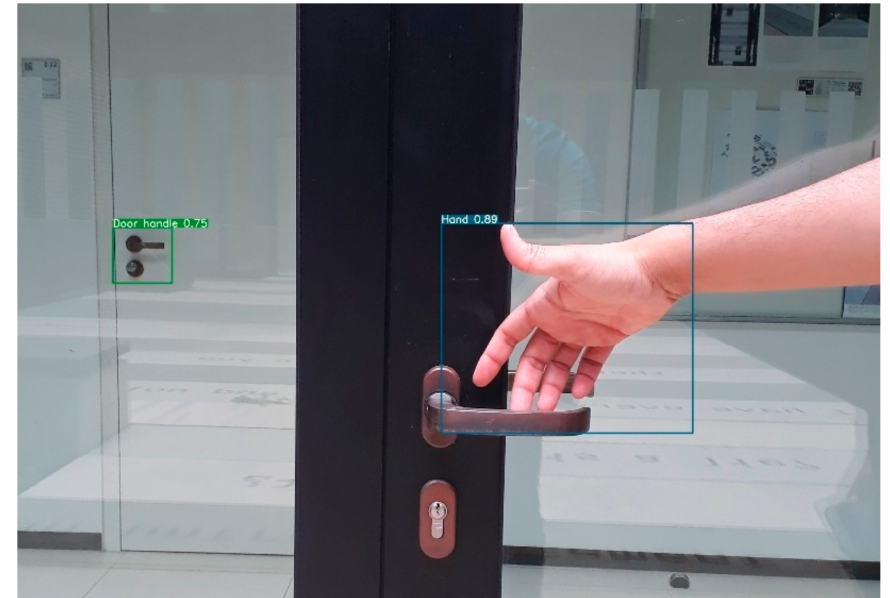
Figure 4. Detection of door knobs and handles by our custom trained machine learning model, based on YOLOv5 [60], Door knob in the backgrounds get detected with a statistical probability of 0.75, which is a relatively small object as compared to the hand in the foreground with a probability of